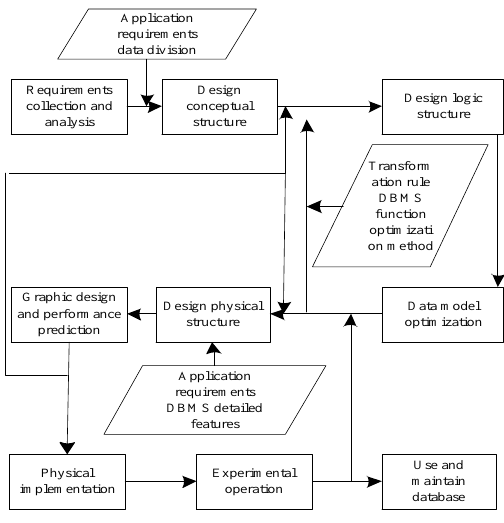
Figure 4. MySQL database design flow chart